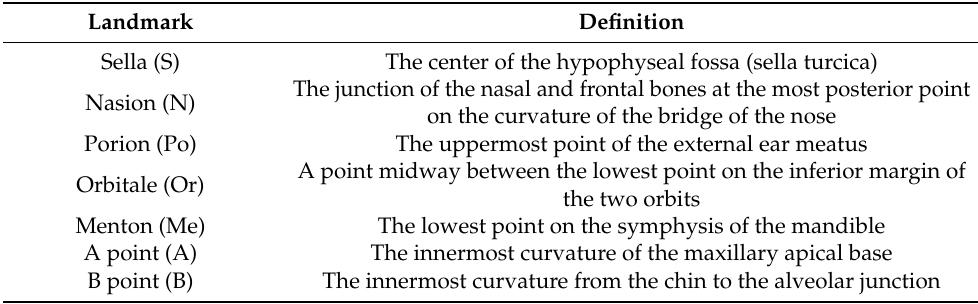
Figure 3. Dental malocclusion based on Angle’s classification: ( a ) Class I molar relationship: the mesiobuccal cusp of the upper first molar occludes the mesiobuccal groove of the lower first molar; ( b ) Class II molar relationship: the mesiobuccal cusp of the upper first molar occludes in front of the mesiobuccal groove of the lower first molar; ( c ) Class III molar relationship: the mesiobuccal cusp of the upper first molar occludes behind the mesiobuccal groove of the lower first molar. 2.5. Assessment of Facial Pattern The Frankfort–mandibular plane angle (FMA) and sella-nasion to mandibular plane (SN–MP) angle were applied to define three facial patterns in orthodontics (Figures 4 and 5). The average angle of FMA was between 27 degrees and 34 degrees, and FMA smaller than 27 degrees was defined as low angle patient, and FMA larger than 34 degrees was defined as high angle patient.